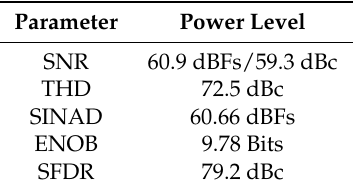
Table 6. Performance parameters of the